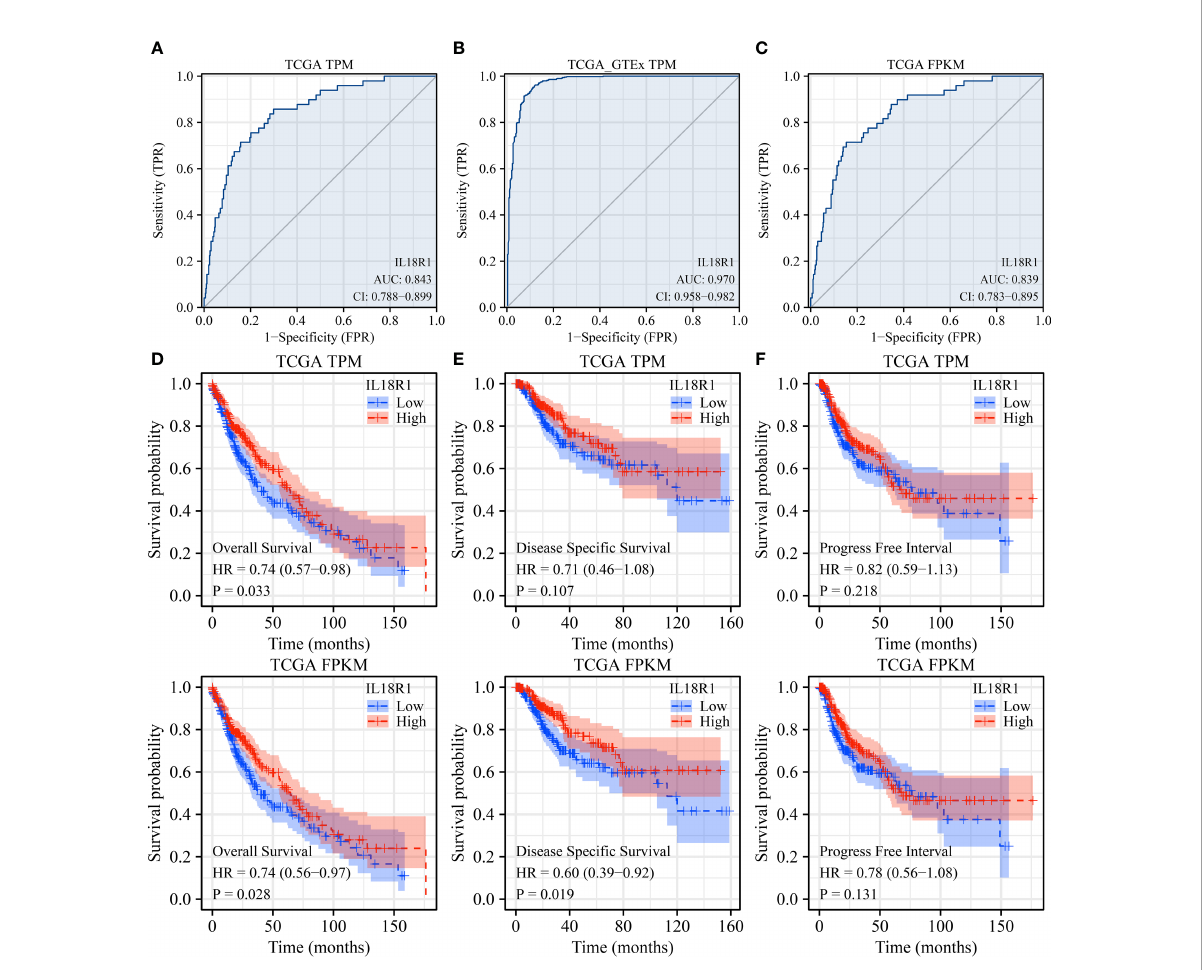
FIGURE 3 IL18R1 plays a role in the diagnosis and prognosis of patients with LUSC based on the data of TPM and FPKM types in the TCGA and GTEx databases. (A – C) The results of ROC analysis; (D) OS; (E) DSS; (F) PFI. Note: TCGA, The Cancer Genome Atlas; GTEx, Genotype-Tissue Expression; LUSC, lung squamous cell carcinoma; TCGA, The Cancer Genome Atlas; GTEx, Genotype-Tissue Expression; OS, overall survival; DSS, disease-speci fi c survival; PFI, progress-free